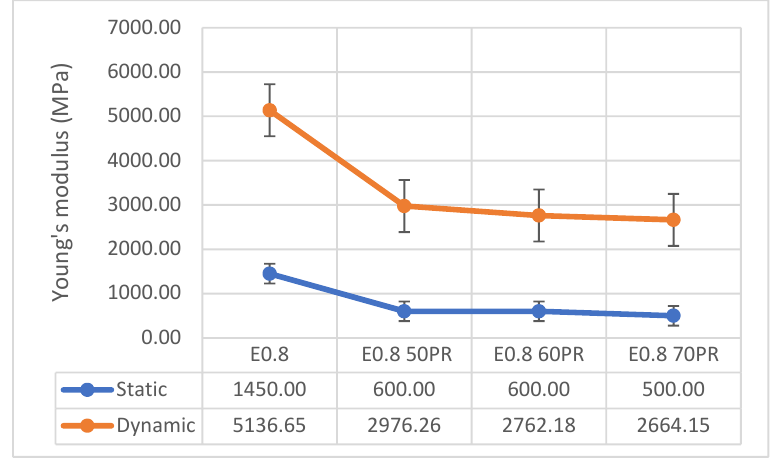
Figure 7. Young’s modulus values (UNE-EN 13279-2).